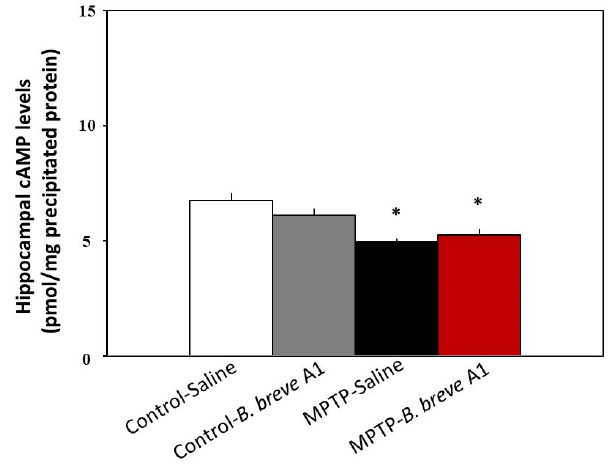
Figure 7. Administration of B. breve A1 to PD mice did not restore the decreased cAMP levels in the hippocampus. cAMP levels are shown as pmol/mg of TCA-precipitated tissue protein. Data are expressed as the mean ± SEM; n = 5–6. * p < 0.01 vs. Control + Saline. 3.5. Effect of B. breve A1 on Neuropsin Protein Expression in the Hippocampus